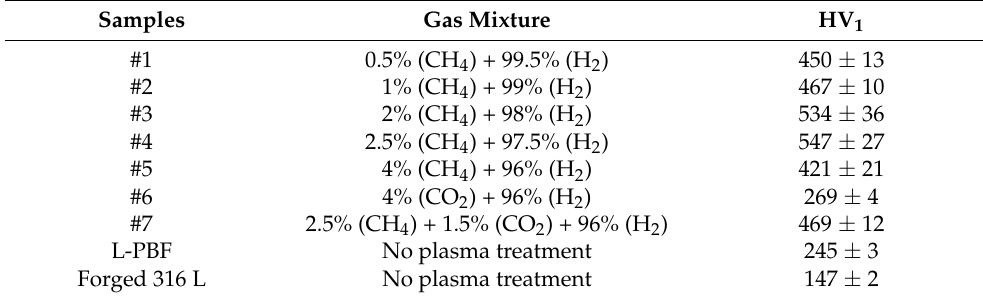
Figure 5. Cross-sections of the samples #2 ( a ) and #5 ( b ). The S-phase layer covers the exposed surface. In ( c ) the untreated material is displayed for comparison. Table 2. Hardness measured with a load of 1000 g on the exposed surface after plasma treatments in different conditions. For comparison the hardness values of untreated L-PBF steel and 316 L steel manufactured by forging are reported